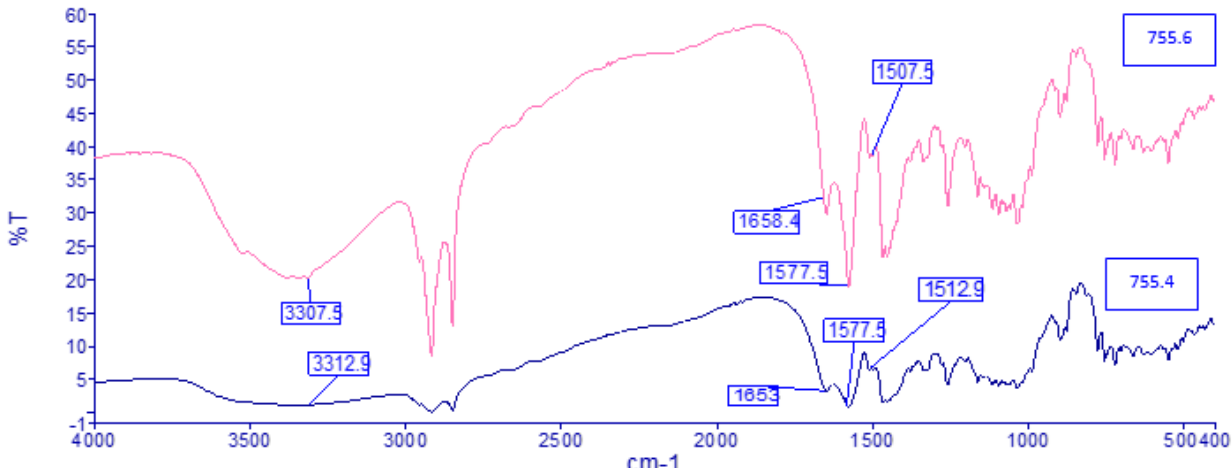
FIGURE 8 - FTIR spectra of all the ingredients initially and after one month at 40 ºC.